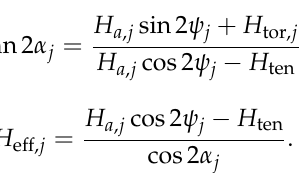
and ( b ) the effective anisotropy field H 2 at different values of the intrinsic anisotropy axis angle ψ tor, 2 tor,2 at different values of the intrinsic anisotropy axis angle ψ 2